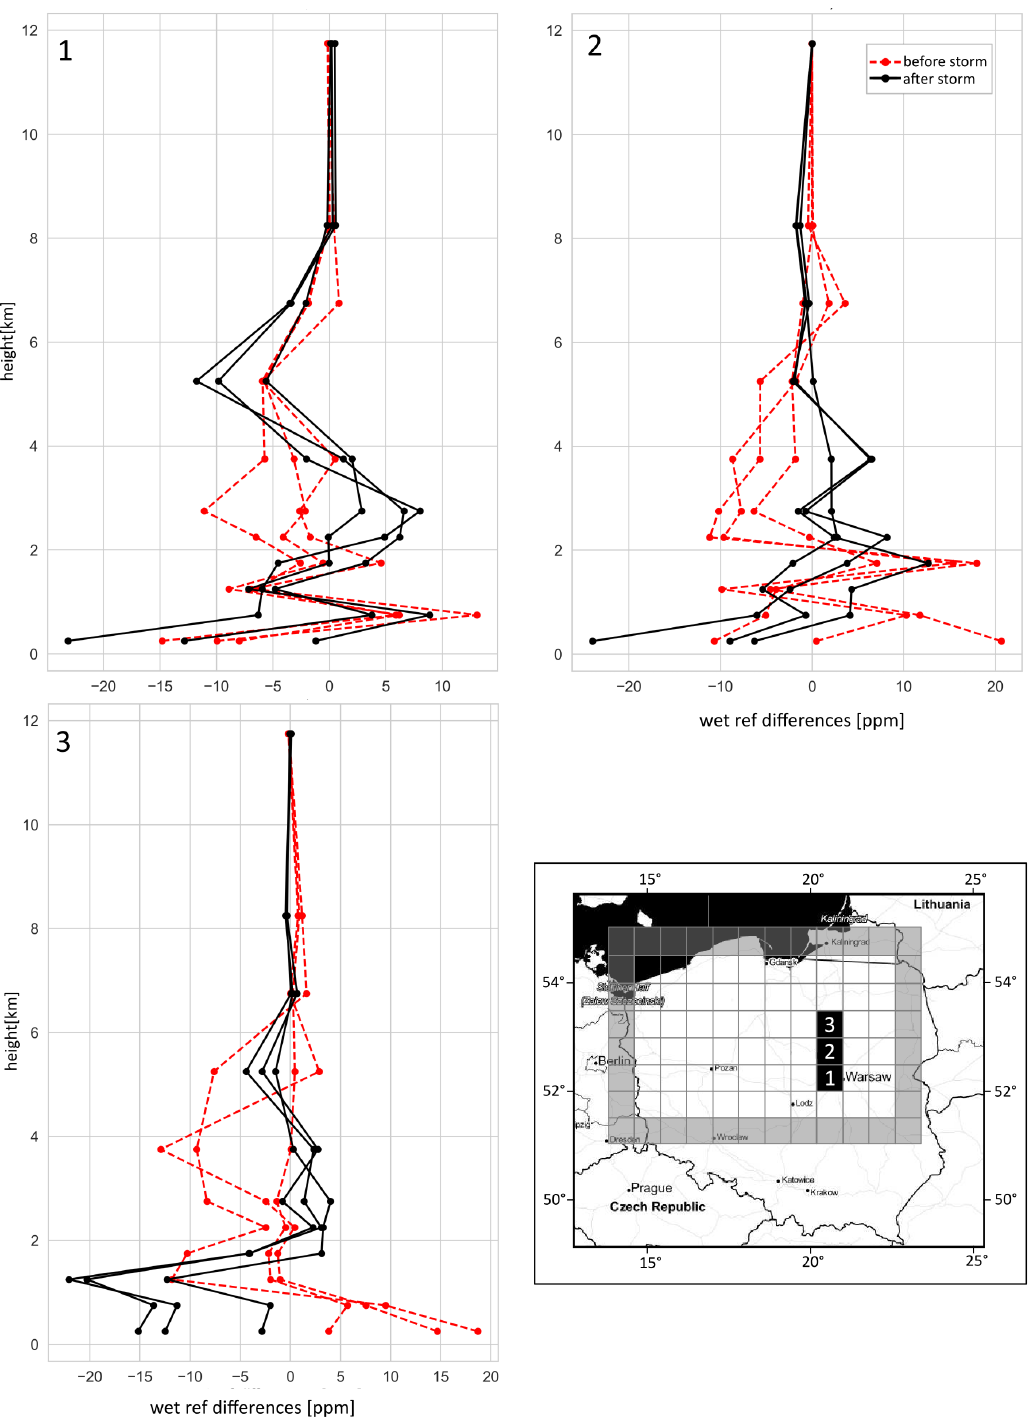
Figure 2. Vertical profiles of Nw change before (red dashed lines) and after (black solid lines) the storm on 12 August 2017. The map shows the location of profiles 1, 2, and